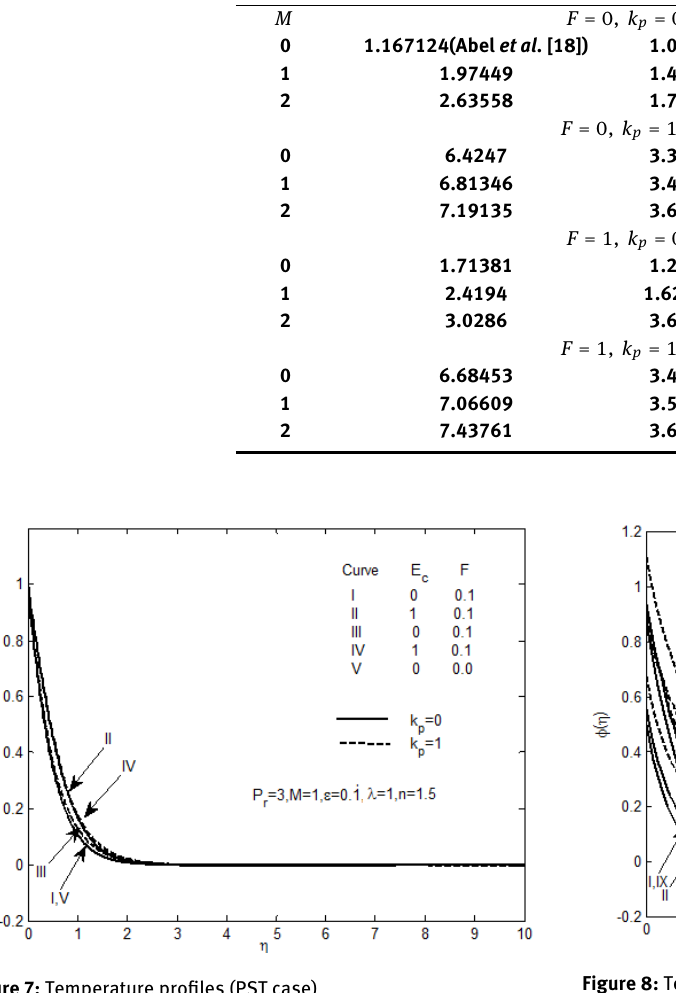
Table 3: Values of skin friction − f ′′ (0) for various values of nM , F and k p Parameters